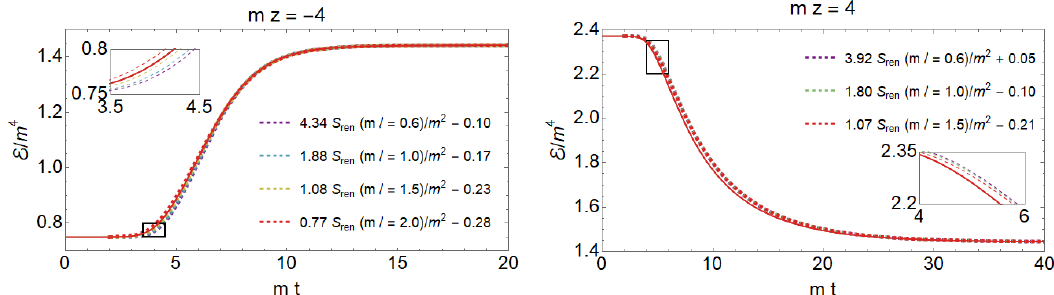
Figure 17: We show the energy density at z = − 4 (shock regime, left) and z = 4 (rarefaction regime, right) together with the time evolution of the holographic en- tanglement entropy S for different lengths. Since the S is sensitive to UV regu- EE EE larisation and length dependence we apply a linear transformation such that at early time (hot / cold) and late time (steady state) the entanglement entropy agrees with the energy density. After this rescaling the curves agree almost exactly, although shorter lengths that are more sensitive to regions closer to the boundary have a small delay (see insets).